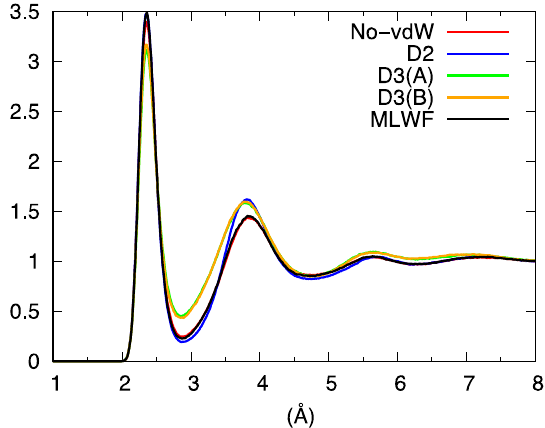
Figure 3. Total pair correlation function for liquid GeSe 4 .